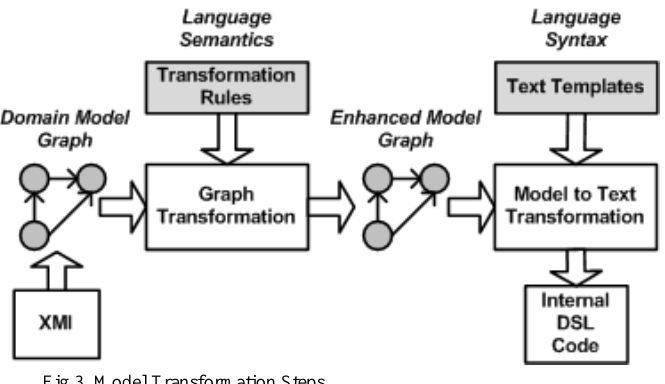
Fig.3. Model Transformation